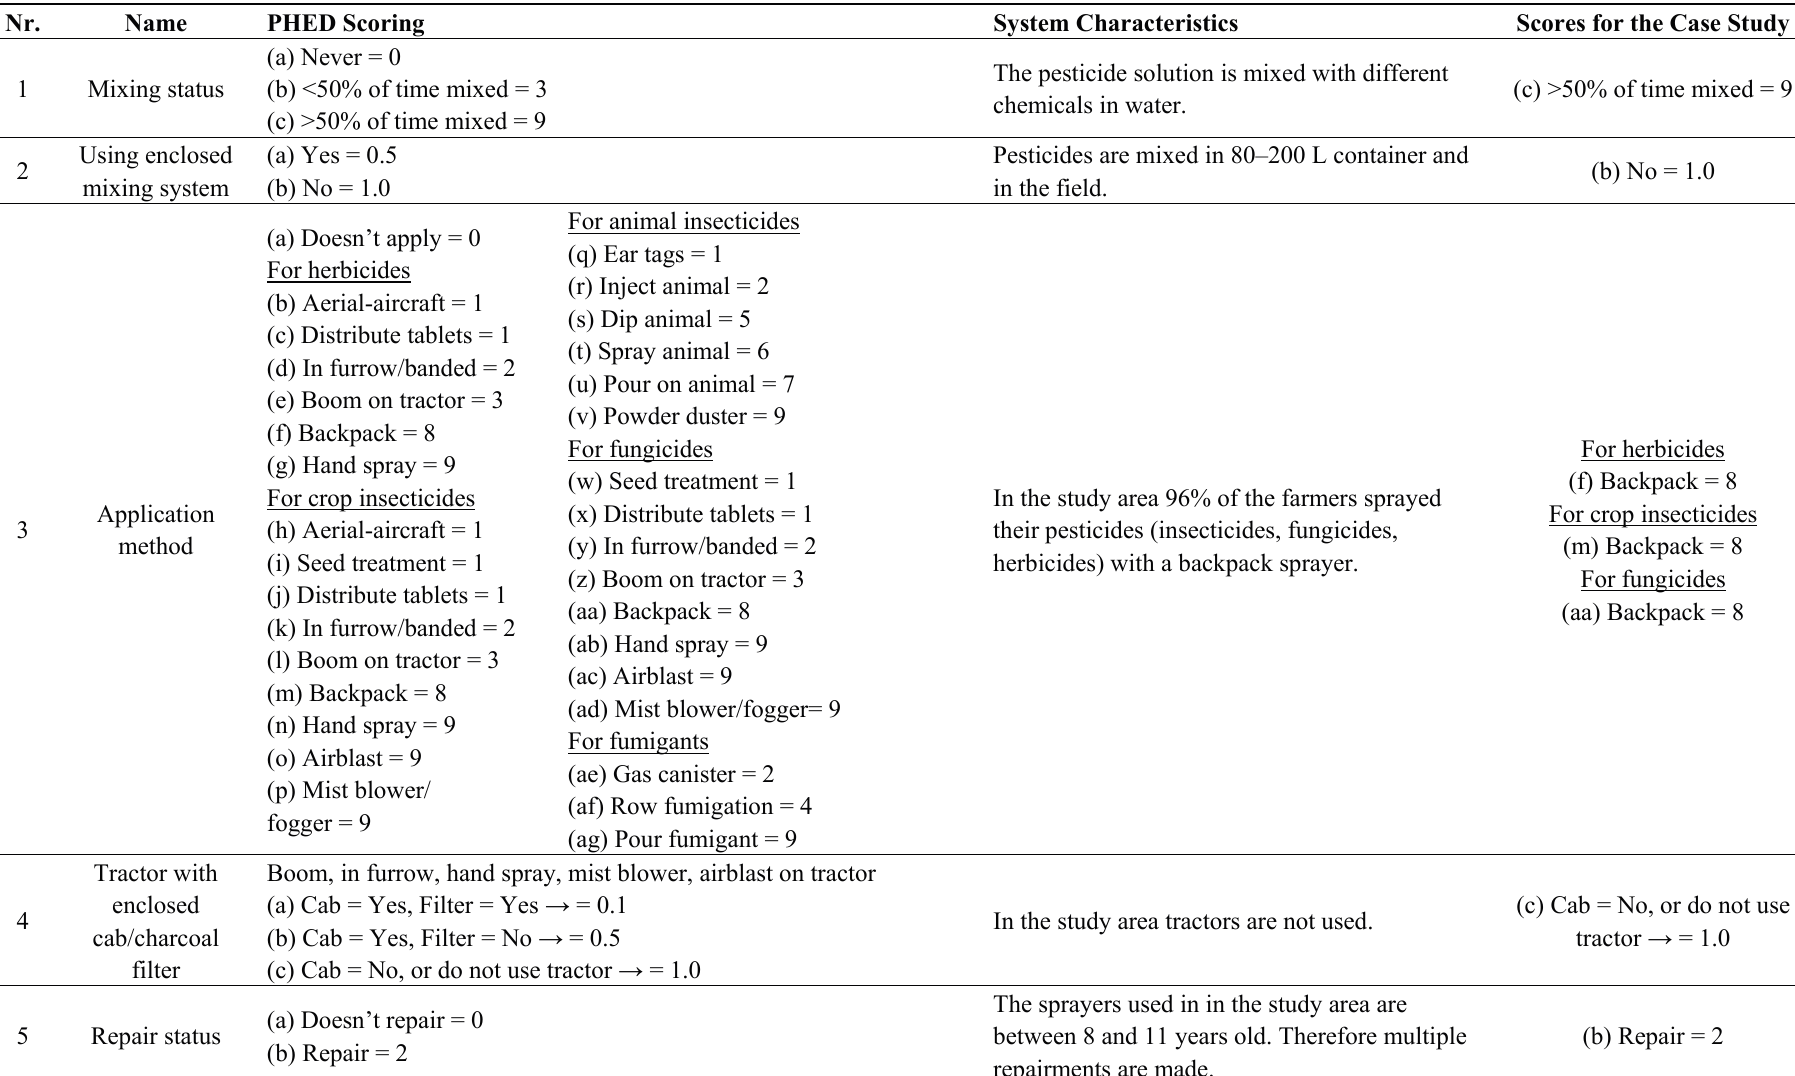
Table A3. PHED Scoring System for the Case